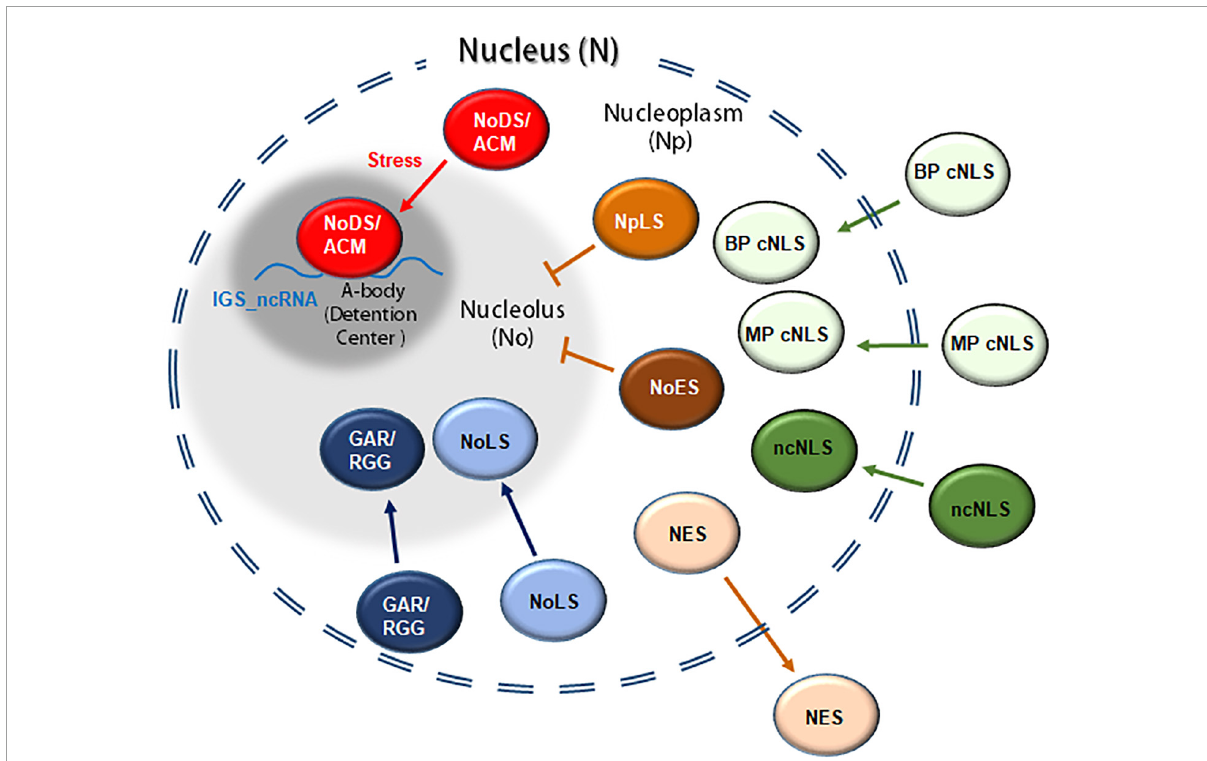
FIGURE3 Representation of proteins containing nuclear and/or nucleolar signals involved in their translocation between the cytoplasm, the nucleoplasm and/or the nucleolus. A classical nuclear localization signal (cNLS) including monopartite and bipartite classical signals (MP and BP cNLS, respectively); ncNLS, non-classical nuclear localization signals; NES, nuclear export signal; NoLS, nucleolar localization signal; GAR, glycine arginine rich domain. In mammalian cells certain proteins might also contain an nucleoplasmic localization signal (NpLS), nucleolar exclusion signals (NoES) and/or amyloid-converting motif (ACM, also referred as nucleolar detention signal or NoDS). In response to heat/acidosis the ACM interacts with IGS-derived lncRNA, forming the A-bodies (or detention centers).